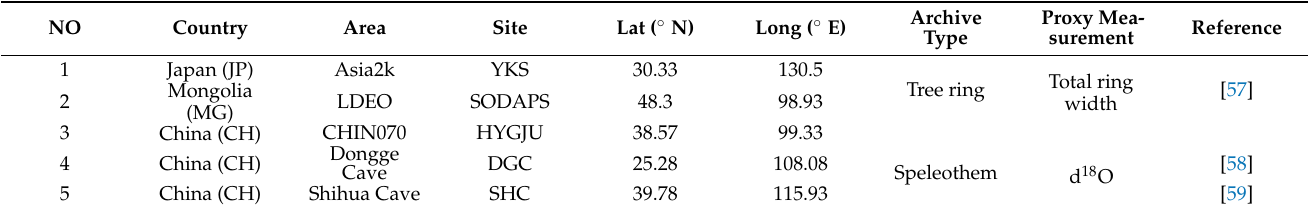
Table 2. Basic information table of the five longest proxy